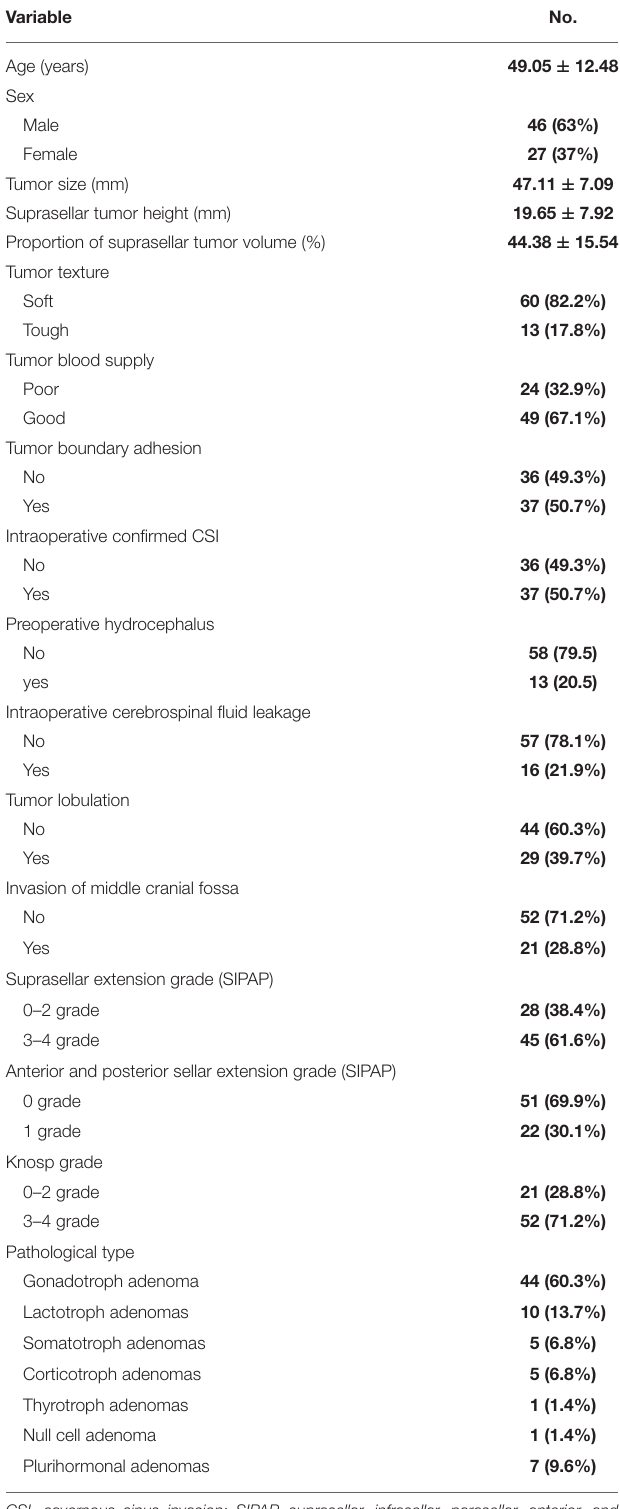
TABLE 1 | Demographic characteristics of 73 patients who underwent microscopic transsphenoidal surgery for giant pituitary adenomas.